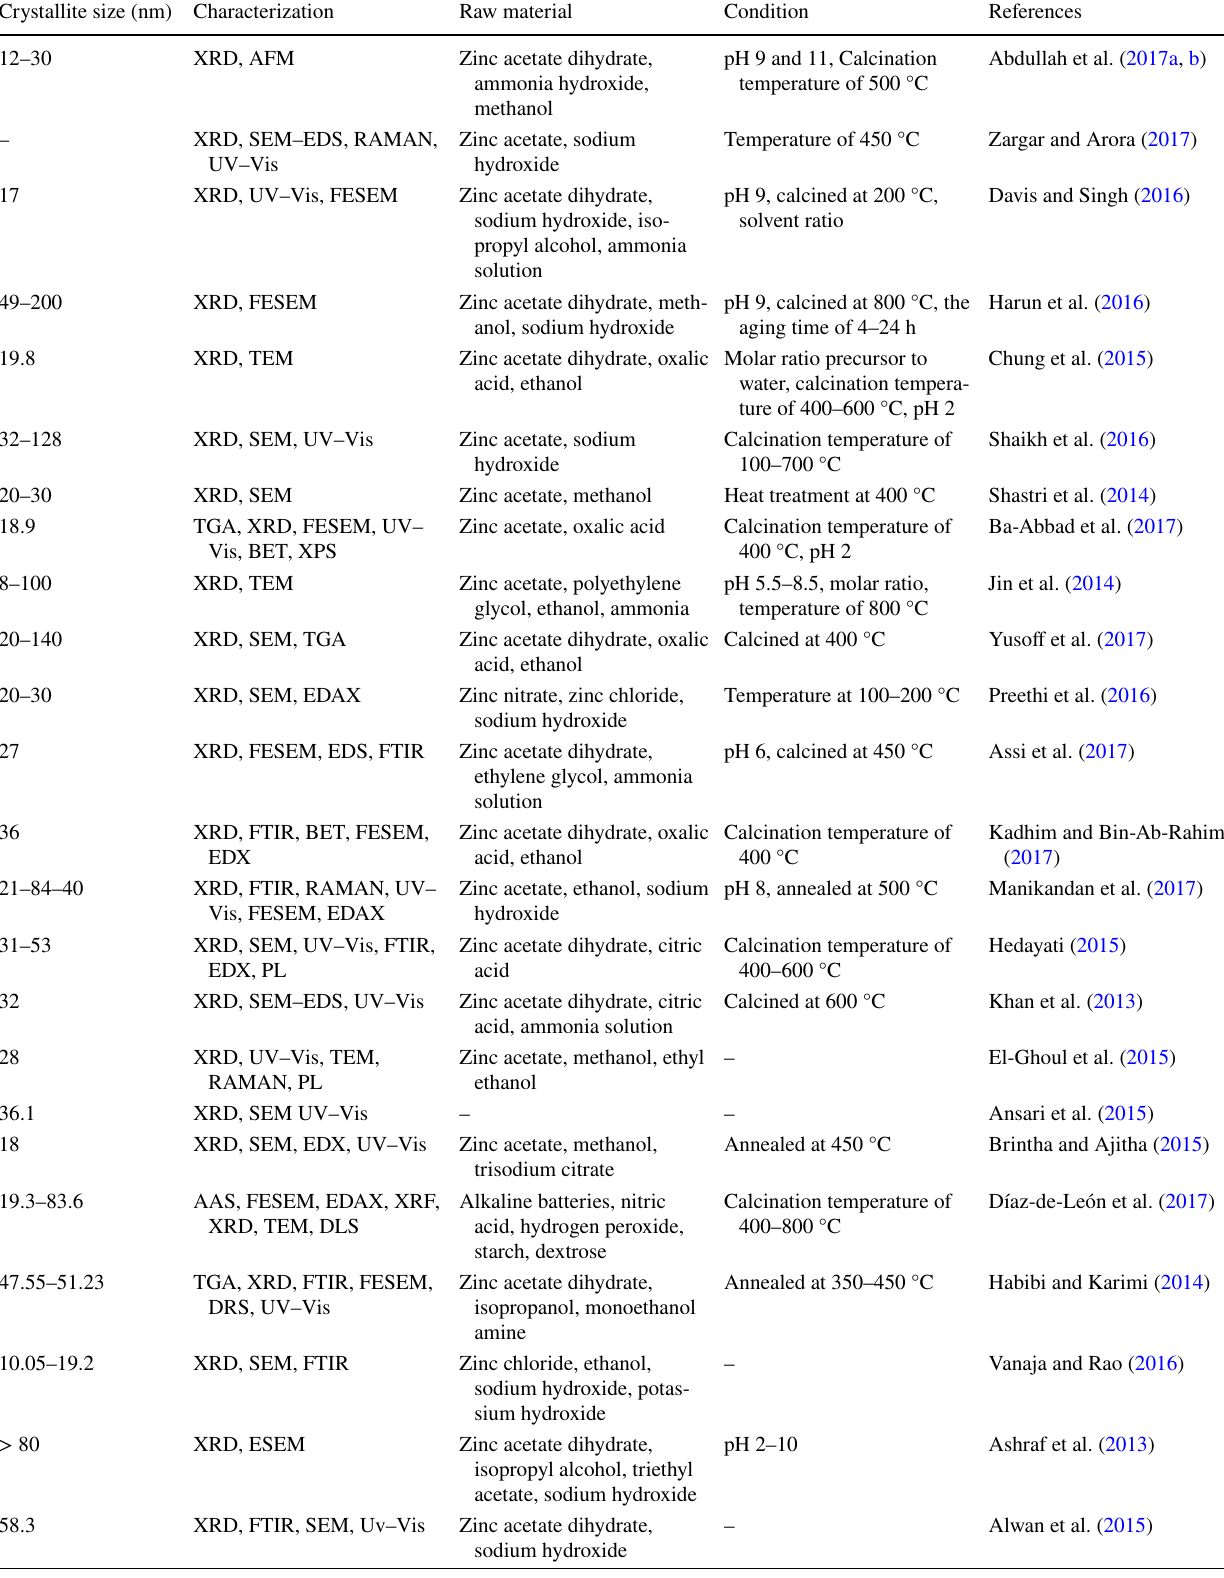
Table 3 Summary of as-synthesized ZnO nanoparticles via solgel methods from 2013 to 2018 Crystallite size (nm)